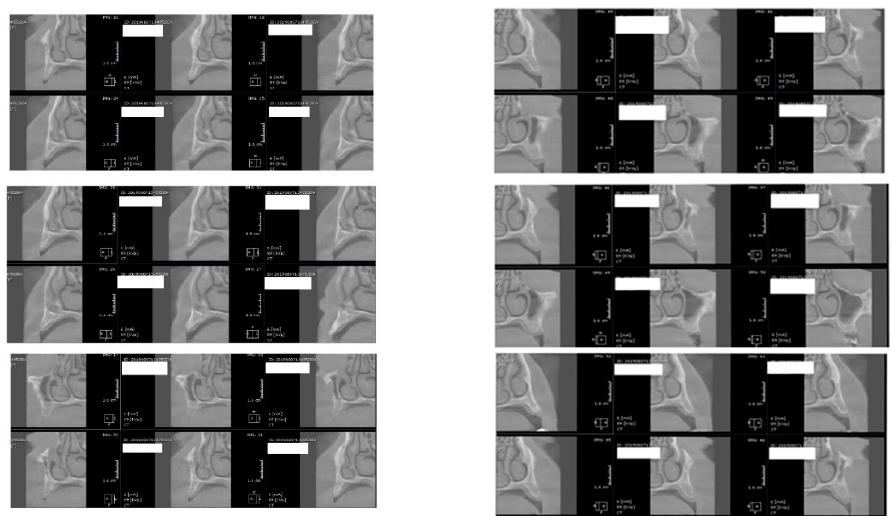
Figure 3. CBCT images used in the study, showing sagittal sections of bone.